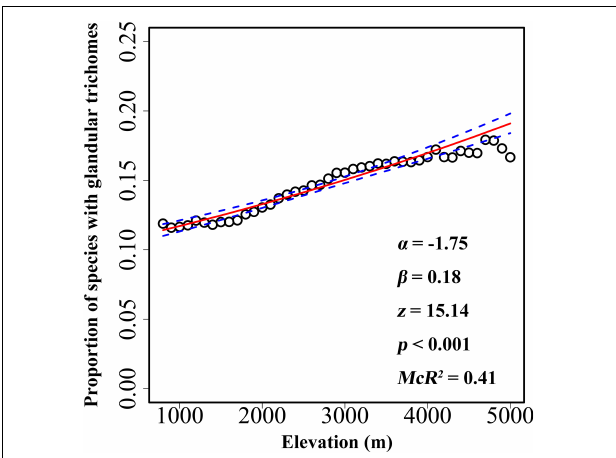
FIGURE 2 | The relationships between glandular trichomes of plant species and elevation for every 100 m belt in the Hengduan Mountains region. The graph was visualized according to the proportion of plants with glandular trichomes, but the analysis was based on the binary data of presence versus absence of glandular trichomes. The fitted line (solid line) and estimated 95% confidence interval (dashed line) display the predicted probability of plants with glandular trichomes as fit by logistic regression models. α and β value was calculated after elevation being